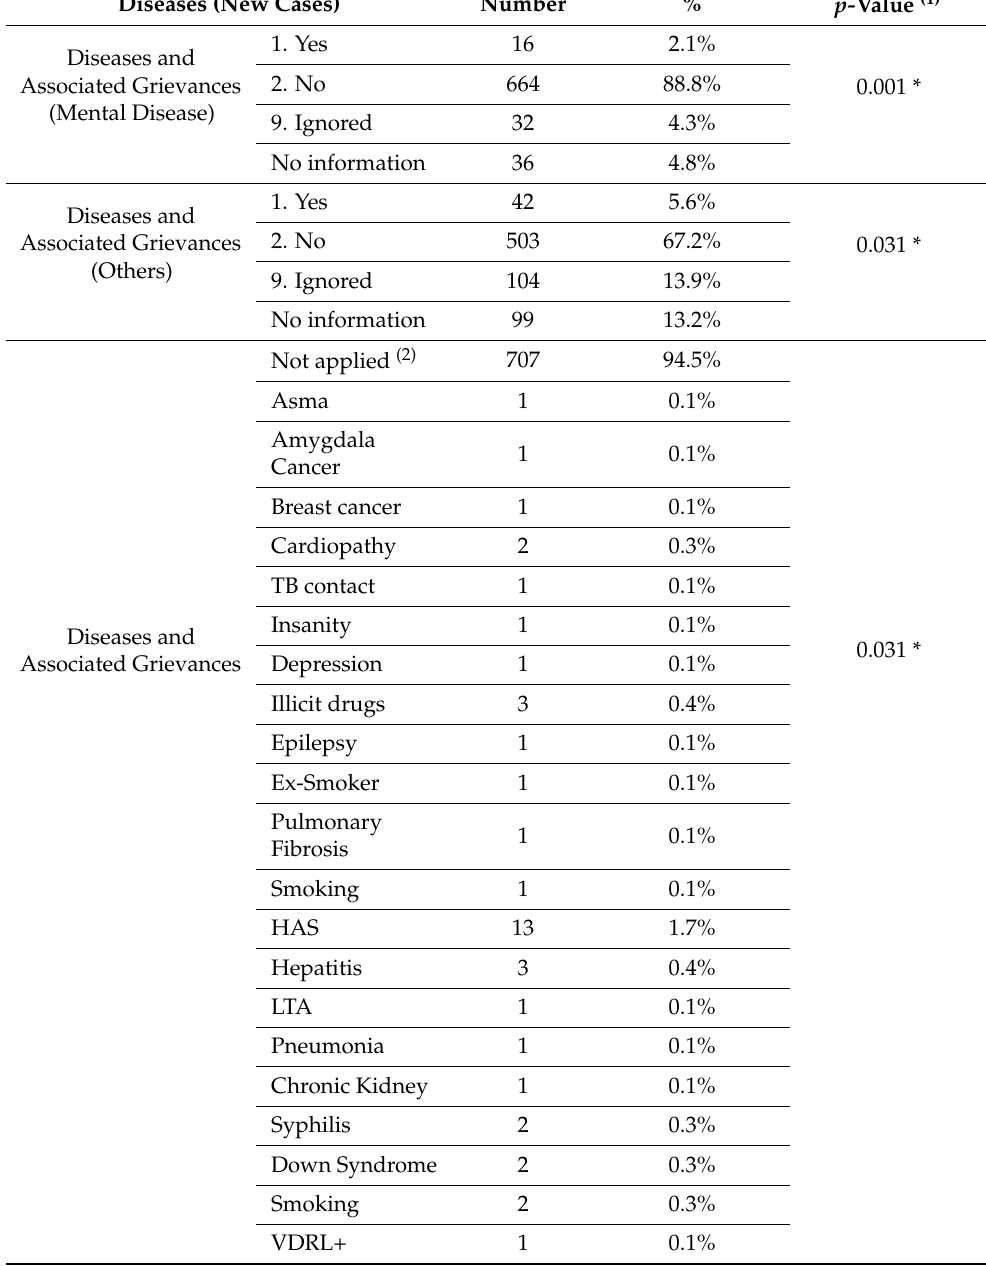
Table 2. Distribution of new cases of human tuberculosis on the Maraj ó Island, Par á -Brazil, according to diseases and